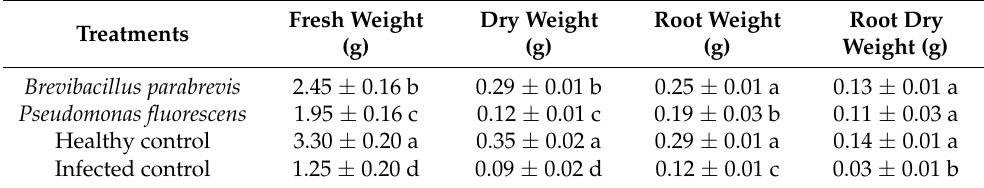
Table 6. Effect of Brevibacillus parabrevis and Pseudomonas fluorescens on fresh and dry weight of cumin plants after inoculation with Fusarium oxysporum